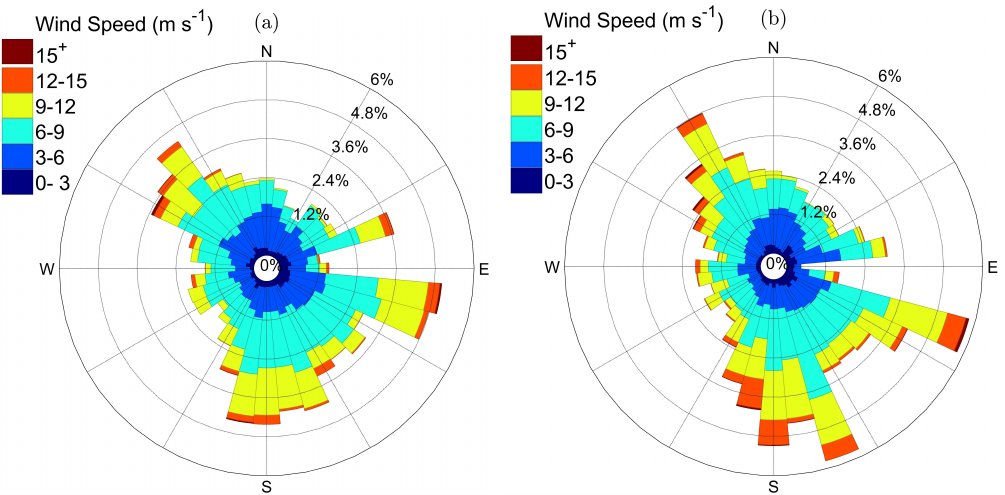
Figure 5. Wind rose at the site of the wind turbine from: ( a ) SCADA data; and ( b ) met tower data. Wind rose were generated after quality checks were applied to the data for the period of study.